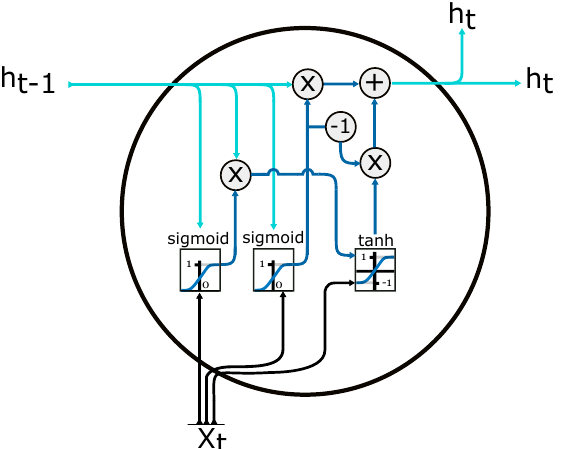
Figure 10. GRU Gate Recurrent Unit cell. X t —input vector; h t —output from current cell; h t − 1 —memory from previous cell; ( (cid:78) ) —element-wise multiplication; ( (cid:76) ) —element-wise sum- mation/concatenation. Adapted from [57].